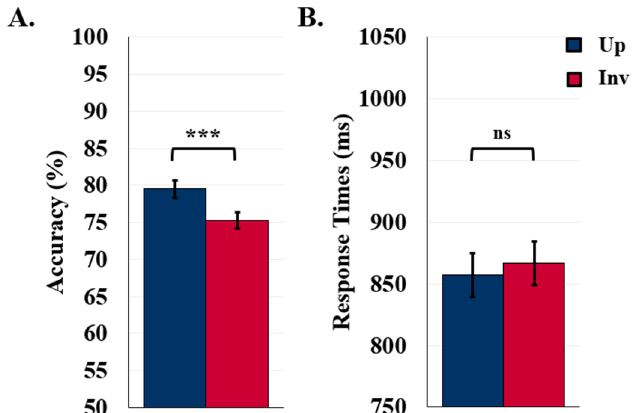
Figure 3. Results for control/labels-absent experiments. ( A ) Object Detection Accuracy ( N = 121) and ( B ) Detection RTs ( N = 113). Error bars represent standard errors. *** indicates p < 0.001 and ns indicates non-significance.